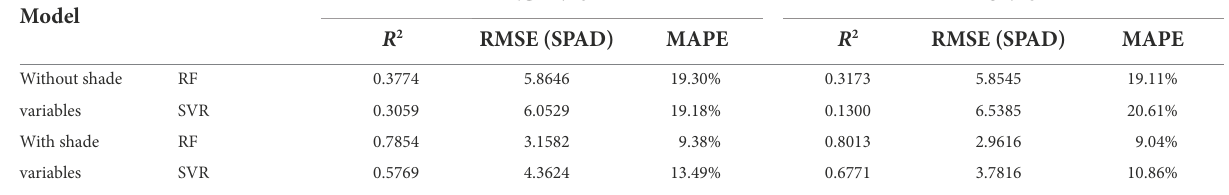
TABLE 9 Evaluation of RF and SVR models for testing samples.